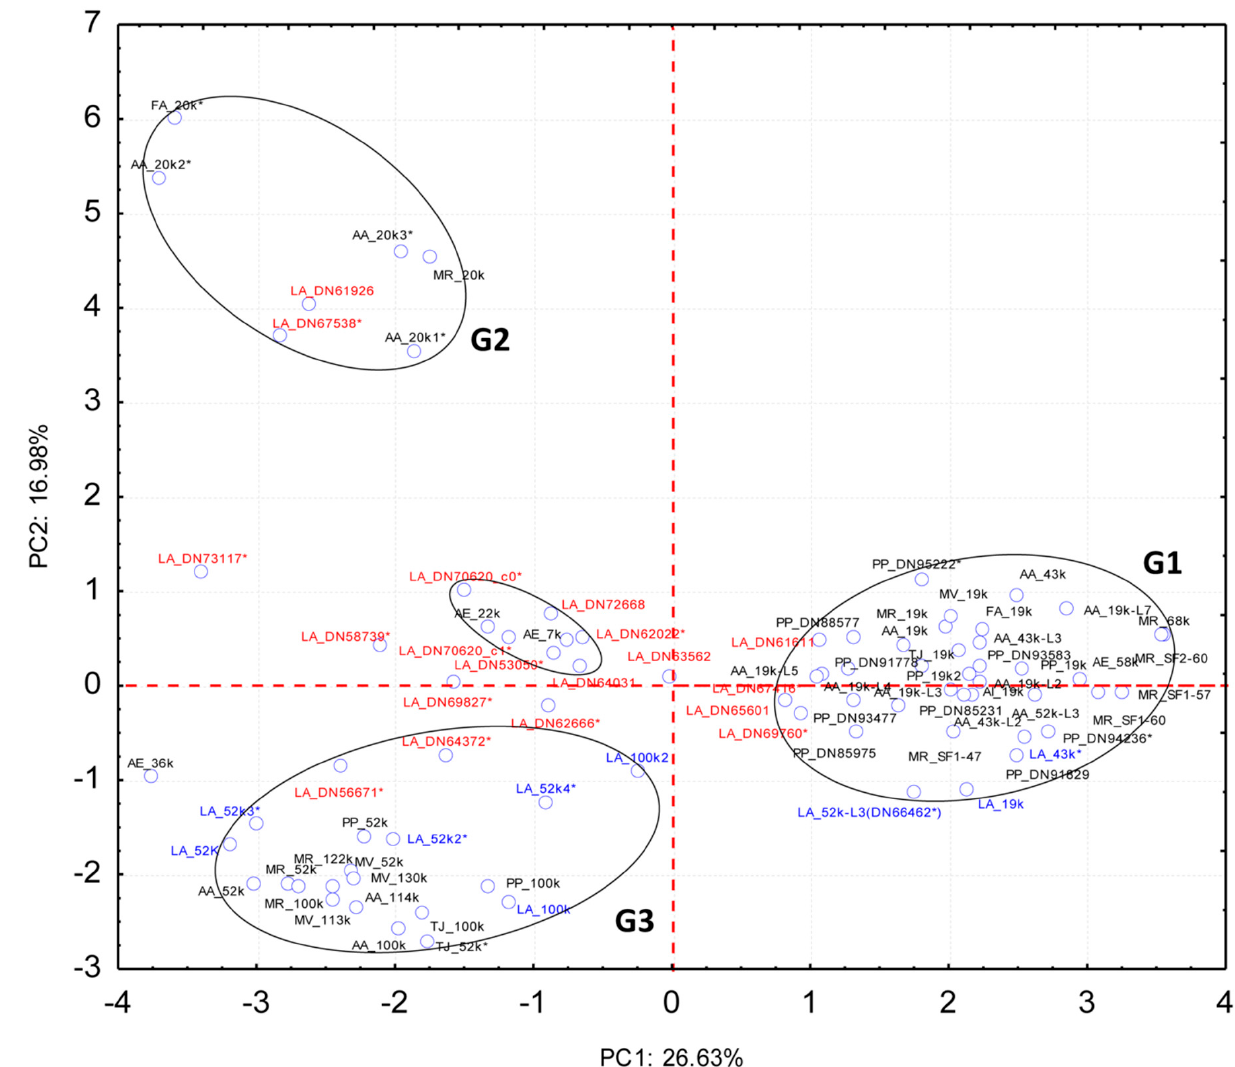
Figure 6. Principal component analysis based on the amino acid relative composition of proteins, considering 53 previously characterized cement proteins, including the 8 annotated L. anatifera annotated identified during the present study through BLAST, and those 20 unannotated proteins identified during the present study, which was not possible to annotate through BLAST or conserved domains. The protein groups previously defined, correspond to surface couple proteins CP19k, -43k, -58k, and -68k (G1), CP20k (G2), and bulk proteins CP52k and -100k (G3) [17]. The two principal components (PC) extracted explain 43.61% of the total variability of data. Blue—Automatically annotated Lepas anatifera proteins; Red—unannotated L. anatifera sequences; Black—cement proteins (CPs) previously characterized, available at NCBI or retrieved from the bibliography. Asterisk marked sequences are